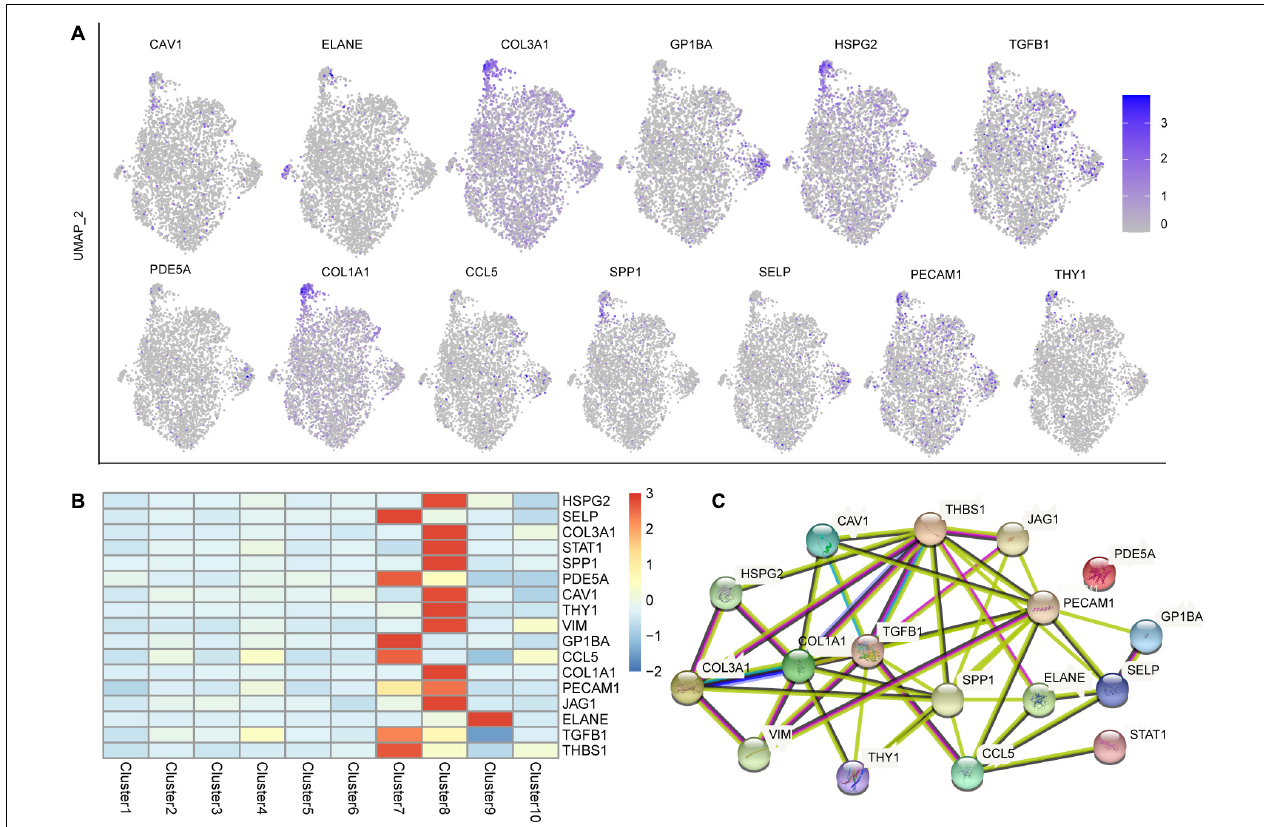
FIGURE 6 | Expression patterns of the liver disease-related gene across tissue sections from the 17 PCW liver. (A) The UMAP plots showing the expression level of liver disease-related genes. The color changed from gray to blue as the gene expression levels increase. (B) Seventeen genes published and linked to liver disease are shown by a heat map based on their average gene expression level in each cell cluster. (C) Protein–protein interaction networks analysis of the 17 liver diseases-related genes displayed based on the degree of complexity of the nodes.